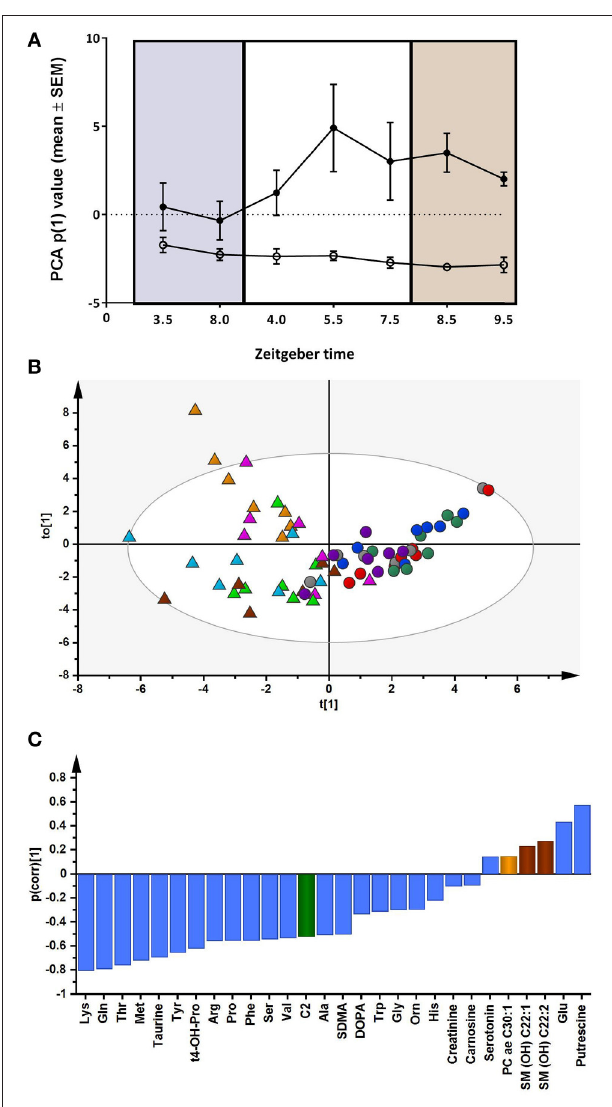
FIGURE 7 | (A) Principal component analysis (PCA) of all the metabolite data ( n = 28 metabolites). The change in mean score ( ± SEM) on PC1 in the control ( n = 5, closed circles) and hyperammonemic animals ( n = 5, open circles) across the time course (baseline, purple; during sleep deprivation, white; after sleep deprivation, orange) is shown. (B) Orthogonal partial least squares discriminant analysis (OPLS-DA) model showing separation by condition [Q2 (cumulative) = 0.575, R 2 X (cumulative) = 0.493; R 2 Y (cumulative) = 0.651]. Each animal is color coded; triangles represent control animals; circles represent hyperammonemic animals. (C) OPLS-DA p (corr) loading plot of control vs. hyperammonemic animals. Negative p (corr) values represent decreased and positive p (corr) values represent increased metabolite concentrations in hyperammonemic animals compared to controls. The metabolite bars are color coded according to metabolite class as follows: amino acids and biogenic amines (blue); acylcarnitines (green); phosphatidylcholine acyl-akyl (PC ae) (light orange); sphingolipids (SM) (brown).